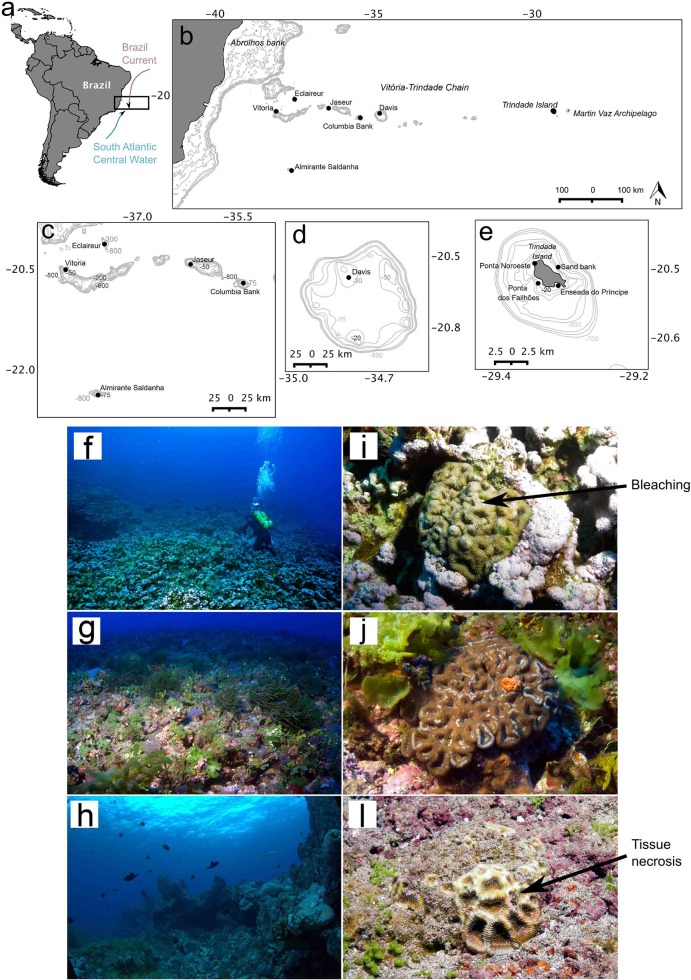
Study area.Data on benthic fish, microbes and nutrients were collected for the Vitoria-Trindade Chain and Trindade Island. Detailed information on the samples and sites can be found in Table 1. (a) Main currents and location of VTC along the Brazilian coast; (b) sampling sites location along the VTC; (c) details of Vitoria, Eclaireur, Jaseur, Columbia Bank and Almirante Saldanha seamounts; (d) details of Davis Seamount sampling site; (e) details of Trindade Island sampling sites; (f) Davis Seamount (CCA reef, Group 1); (g) Jaseur Seamount (fleshy algae dominated rhodolith beds, Group 2); (h) Trindade Island (turf algae dominated rocky reef, Group 3); corals from (i) CCA reef, (j) rhodolith bed and (l) rocky reef. The maps were generated using Qgis software [68]. Photo credit: Ronaldo Francini-Filho.